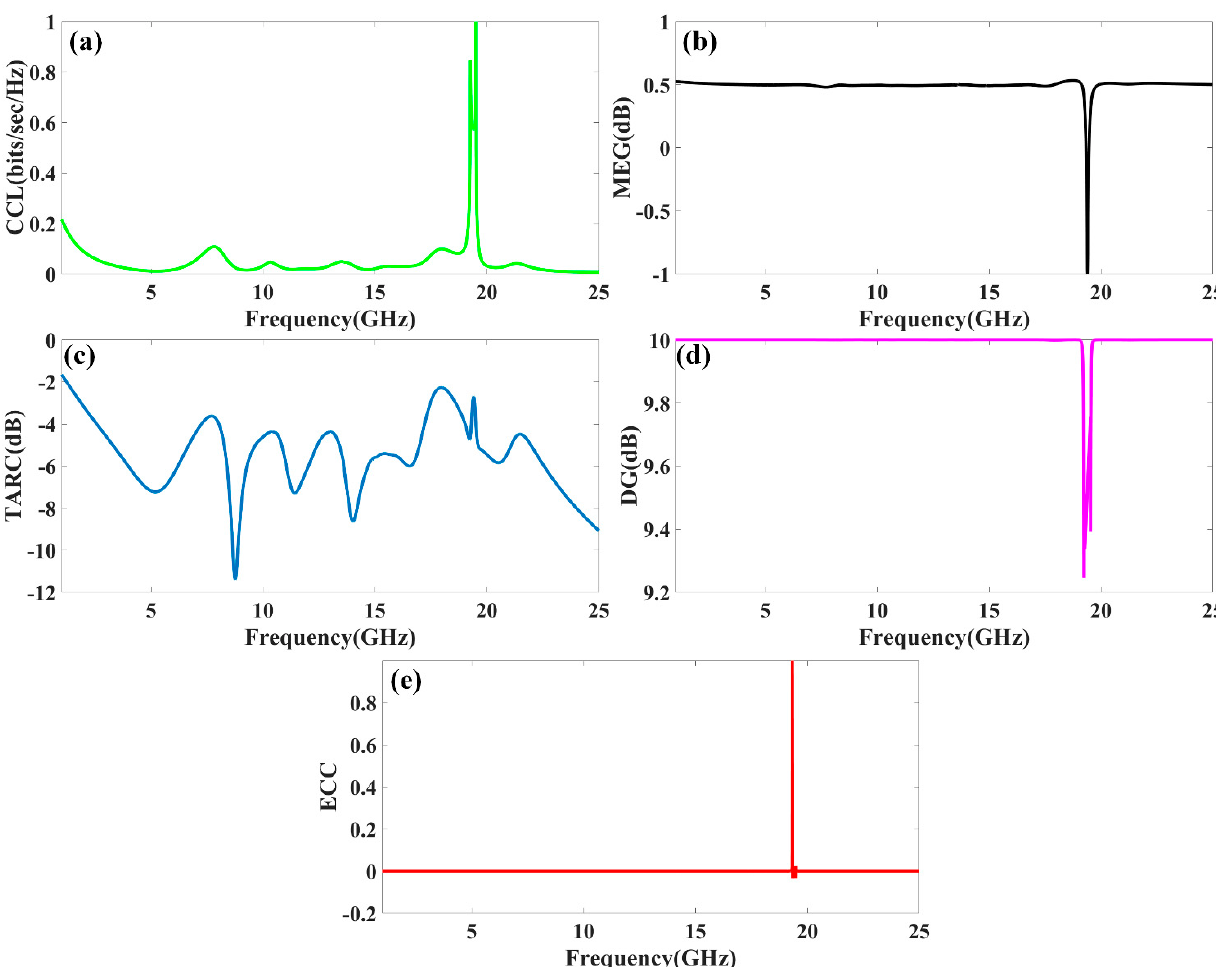
Figure 13. Variation in different MIMO antenna parameters ( a ) CCL, ( b ) MEG, ( c ) TARC, ( d ) DG, and ( e ) ECC for the design 4 antenna structure.